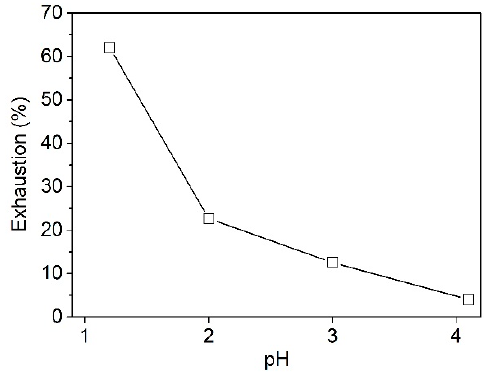
Figure 1. Effect of pH on the uptake of PA by wool.